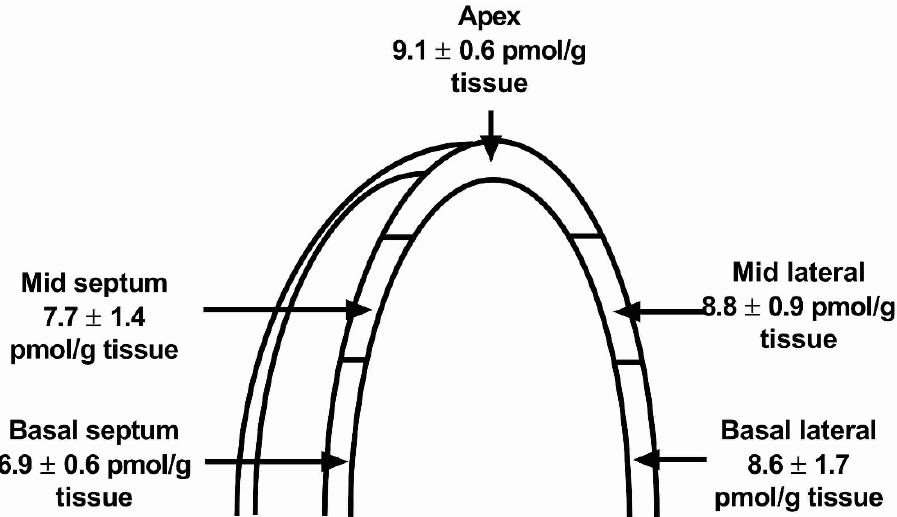
Figure 4. Ventricular expression of procholecystokinin. The different anatomical sections of the left ventricle represent sections normally visualized and evaluated by 2-dimensional echocardiography. Modified from [69].